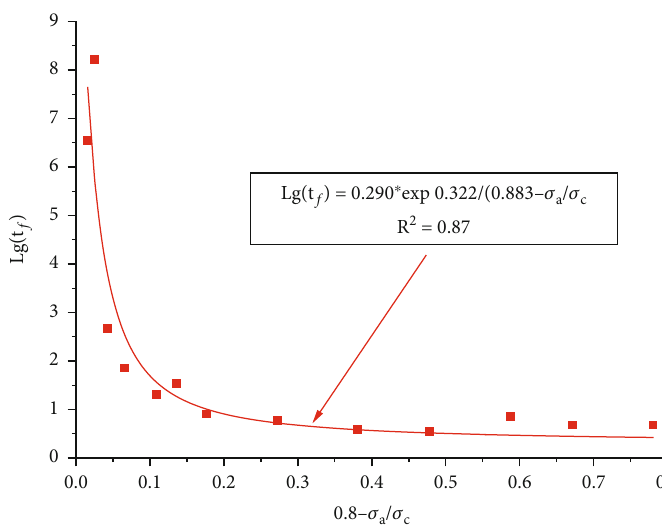
Figure 4: Relationship curve of σ